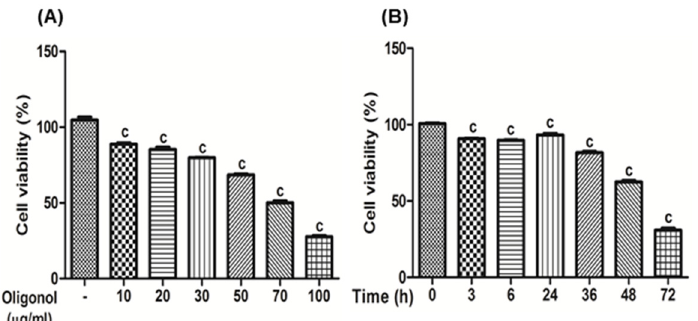
Figure 10. Oligonol suppresses hepatic stellate (HSC)-T6 cell proliferation. Cells (1 × 10 4 /well) in a 96-well plate were allowed to adhere overnight, and then the culture medium was replaced with fresh, 10% serum DMEM. ( A ) HSC-T6 cells were treated with a series of concentrations of oligonol for 48 h. ( B ) HSC-T6 cells were treated with 70 μ g/mL of oligonol for 0, 3, 6, 24, 36, 48, and 72 h, and untreated cells. Values are the mean ± SE ( n = 3). c p < 0.001 vs. the control group.